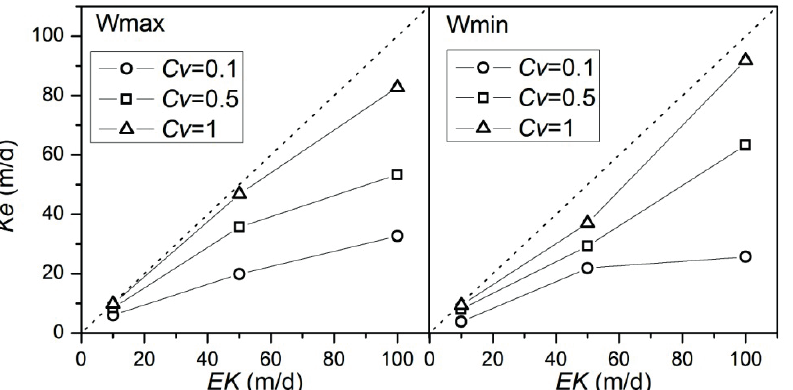
Fig. 4 The effective hydraulic conductivity varied by the mean of given hydraulic conductivity at well Wmin and well Wmax with respect to Cv = 0.1, 0.5 and 1,